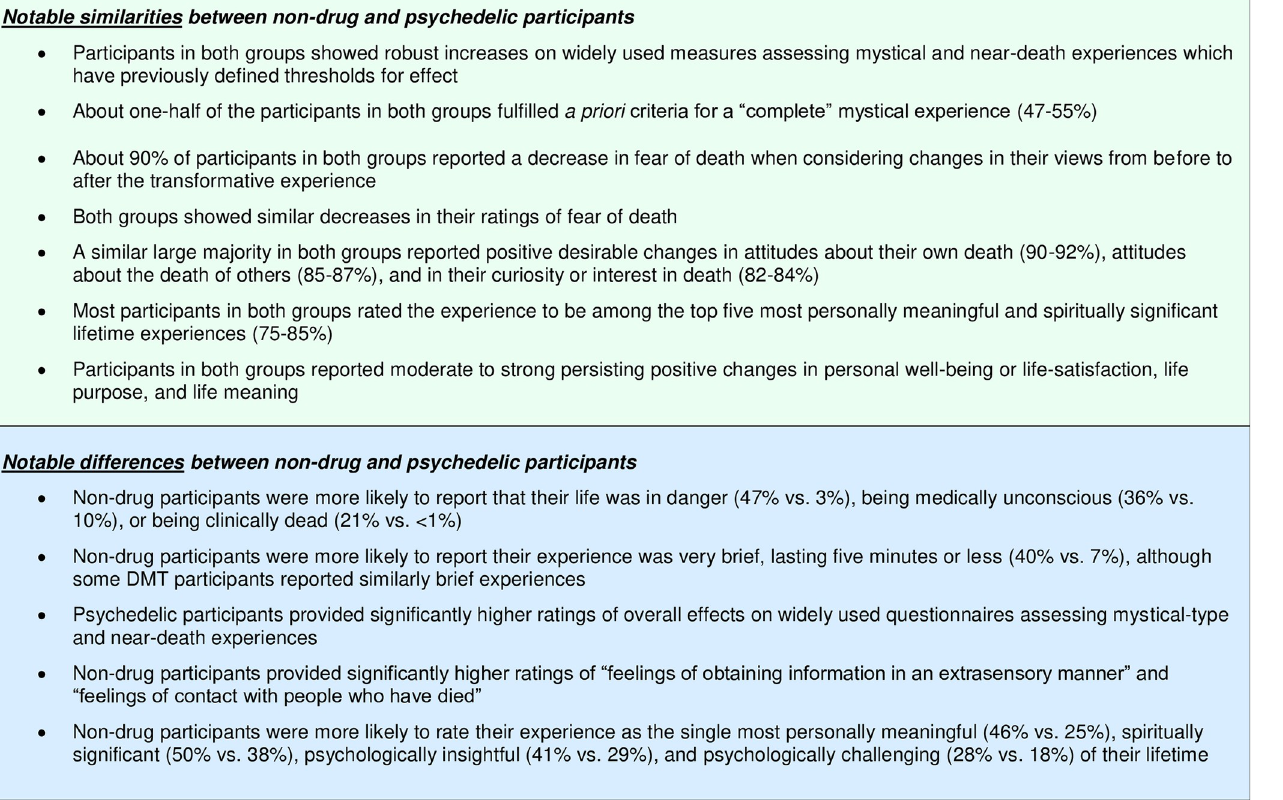
Fig 1. Similarities and differences in experiences between non-drug and psychedelic participants. Summary of notable similarities and differences in the circumstances of the experience, the subjective features of the experience, and the persisting changes attributed to the experience between the Non-Drug Group (naturally occurring experiences) and the combined Psychedelic Group (psychedelic-occasioned